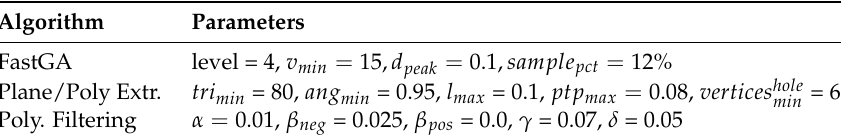
Table 14. Polylidar3D Parameters for the Basement Mesh.